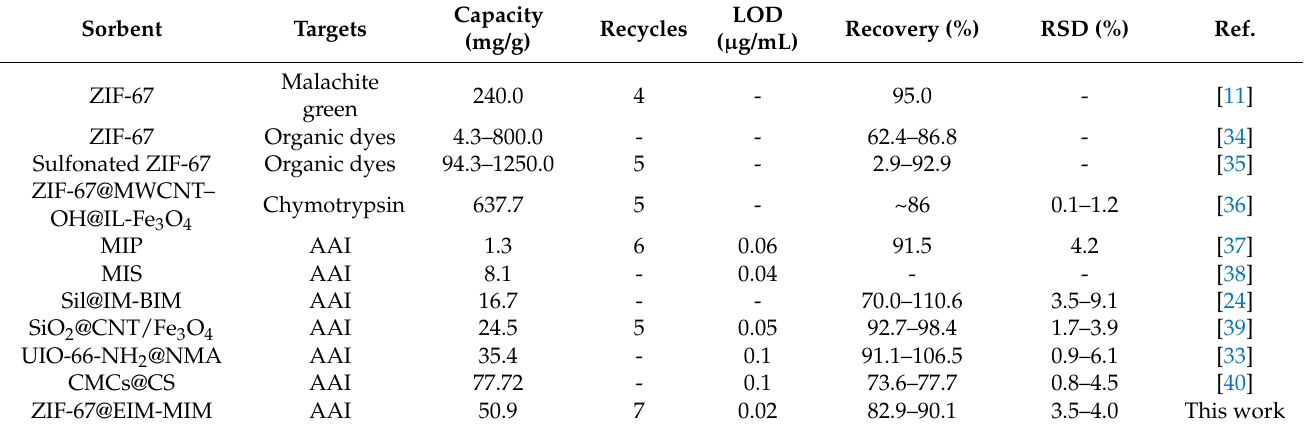
Table 2. Comparison of the proposed material with the previous studies.